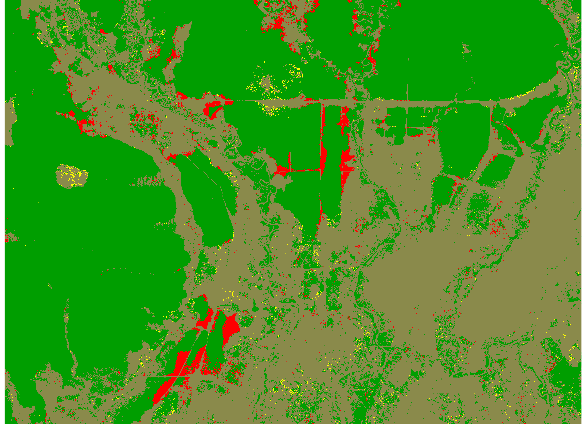
Figure 7. Forest loss and gain for 2002-2003 at local scale.